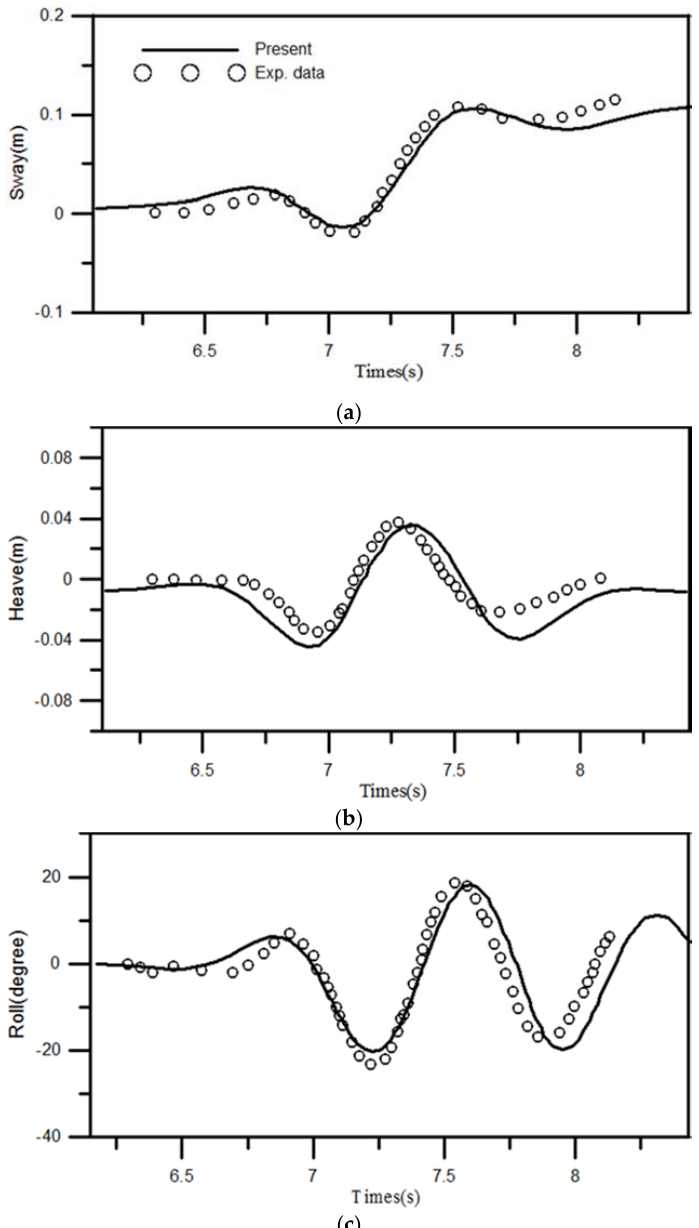
Figure 23. Time-based variations of the floating body motions during the interaction with the wave packet ( a ) sway, ( b ) heave, and ( c ) roll.